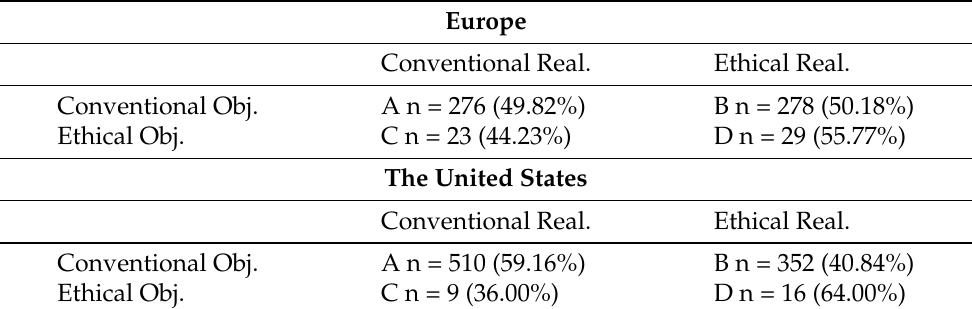
Table 3. Categorization of funds according to de jure / de facto SRI.